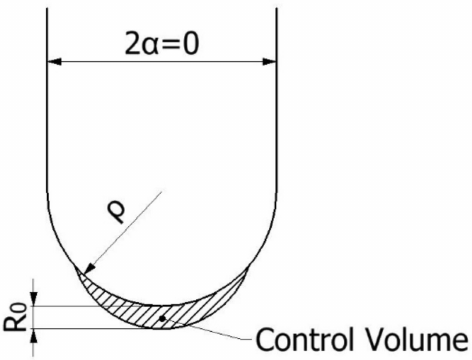
Figure 1. Control volume (area) for U-notch (2 α = 0) under mode I